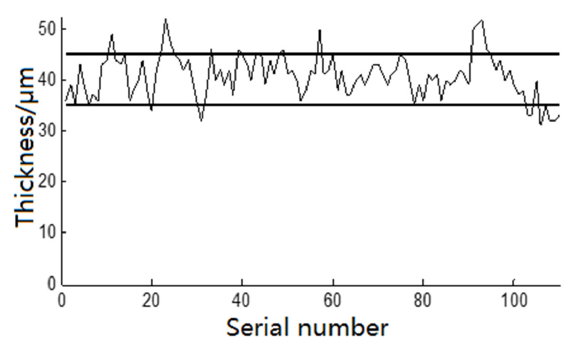
Figure 13. Curve of the coating thickness on the automobile body.